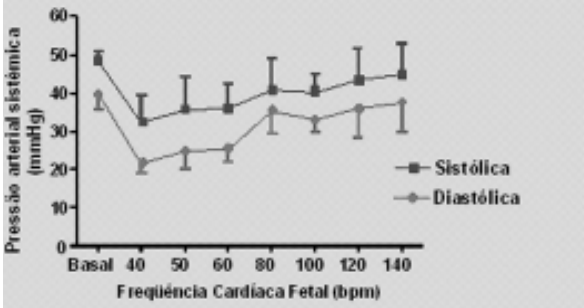
Fig. 4A - Relação da pressão arterial sistêmica fetal com a freqüência cardíaca fetal. n = 4, Valores = média ± desvio padrão